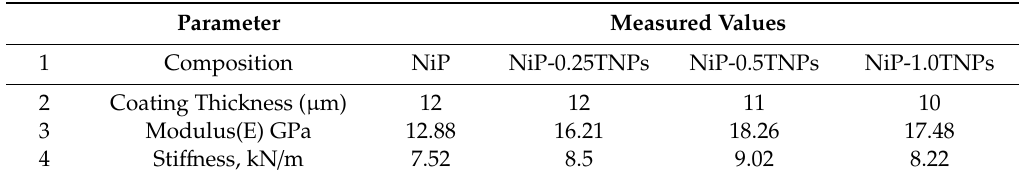
Table 4. Coating thickness and nanoindentation mechanical results for NiP, NiP-0.25TNPs, NiP-